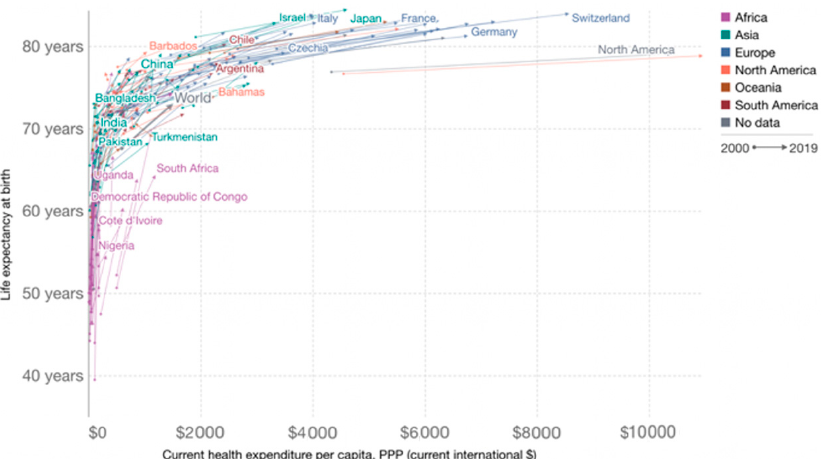
Figure 2. Trends in life expectancy and health expenditure by country, 2000–2019. Note: This visualization shows the cross-country relationship between life expectancy at birth (ordinate data) and healthcare expenditure per capita (abscissa). Arrows connect these two observations, showing the change over time of both measures for all countries in the world. China is at the intersection of low-value-based healthcare and value-based healthcare. Source: Image from https://ourworldindata.org/ (accessed on 20 May 2022).